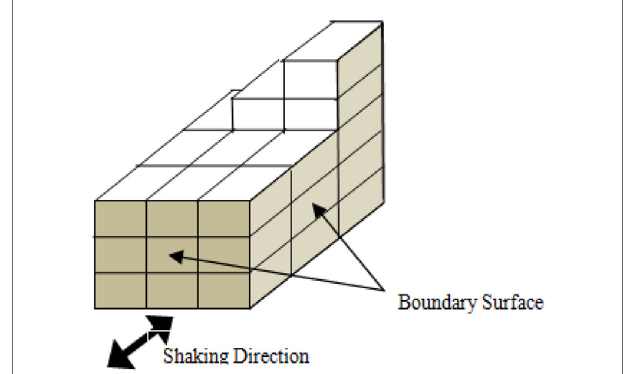
FigUre 2 | image of inner field .